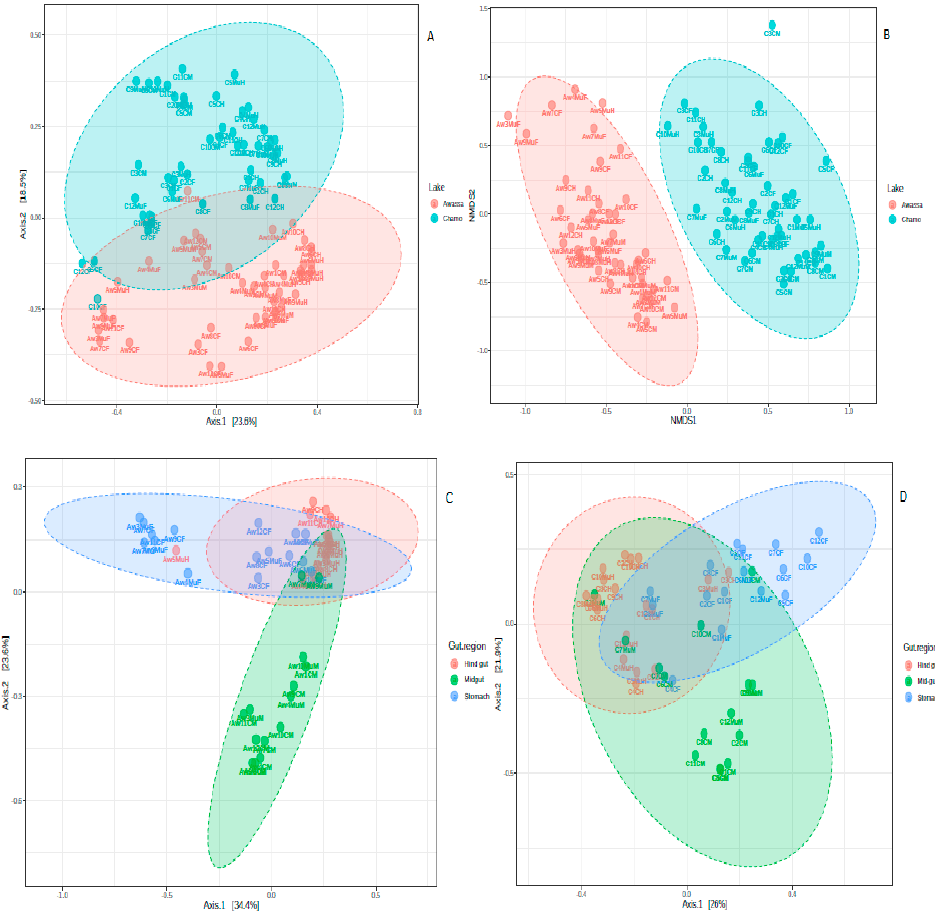
Figure 4. Principal coordinate analysis (PCoA) and non-metric multidimensional scaling (NMDS) based on the Bray-Curtis index distance method. ( A ) PCoA plot of all samples based on the two lakes. ( B ) NMDS plot of all samples based on the two lakes. ( C ) PCoA plot of samples from Lake Awassa. ( D ) PCoA plot of samples from Lake Chamo. Each dot represents one sample.